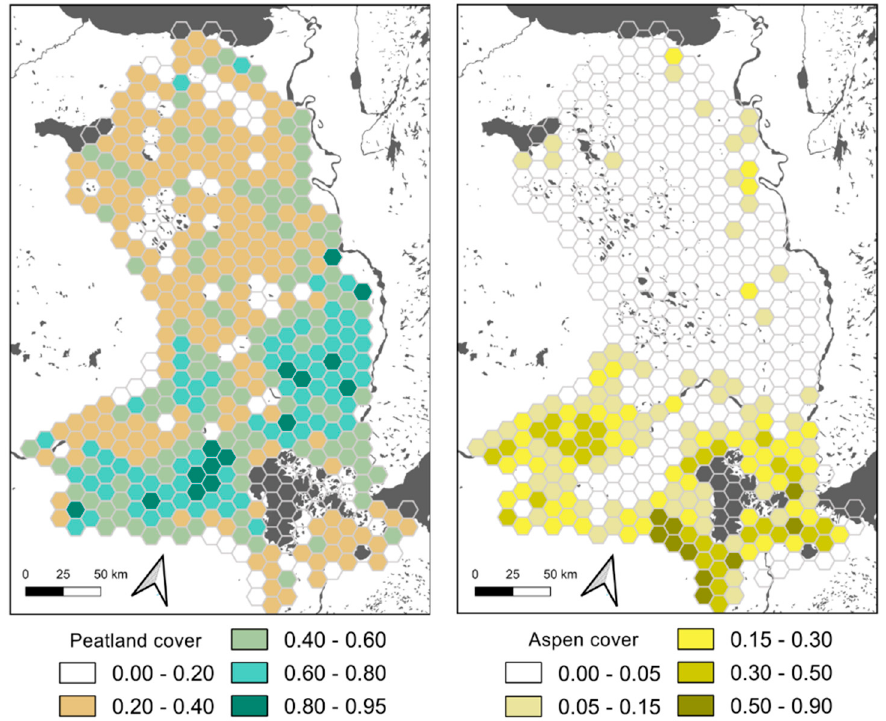
Figure A5. Fractional cover of peatland and aspen per 10 kha hexel. Breaks for peatland and aspen land cover classes were calculated using the Jenks method. Peatland cover <20% and aspen cover <5% is shown as a transparent hexel.